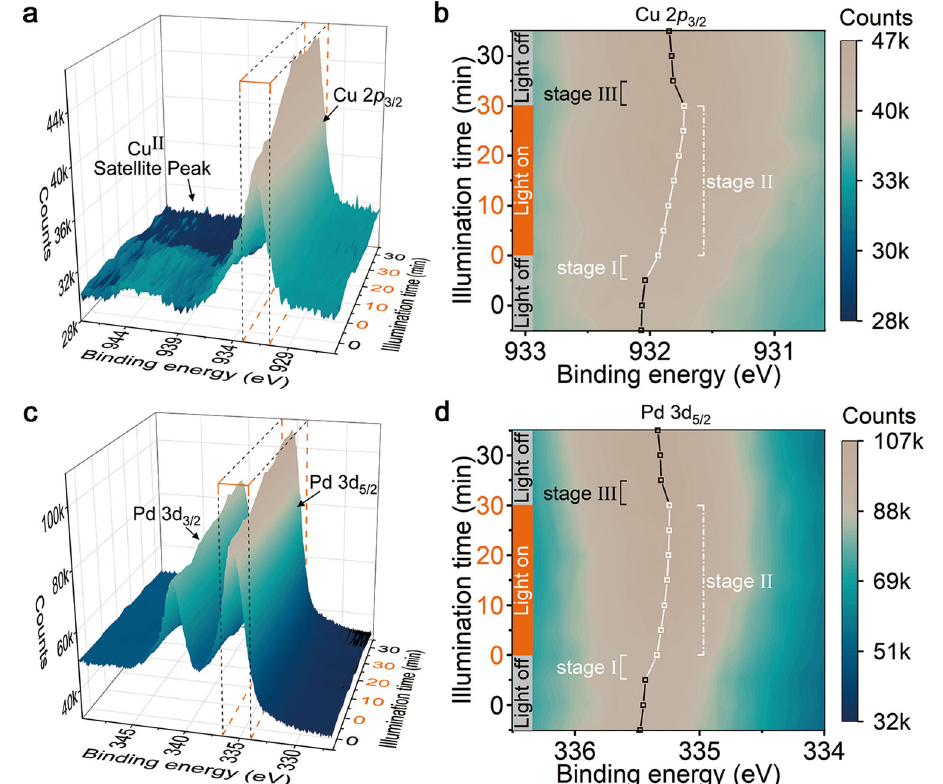
Fig. 2 | Deciphering plasmon-induced electron behavior via in situ NAP-XPS characterization. a and b In situ NAP-XPS spectraof Cu 2 p 3/2 ( a ) and contour plot forthe ampli fi ed top viewof the selectedbox-shaped area ( b ). c , d In situ NAP-XPS spectra of Pd 3 d 5/2 ( c ) and contour plot for the ampli fi ed top view of the selected box-shaped area ( d ). The in situ NAP-XPS data are recorded continuously for 1h